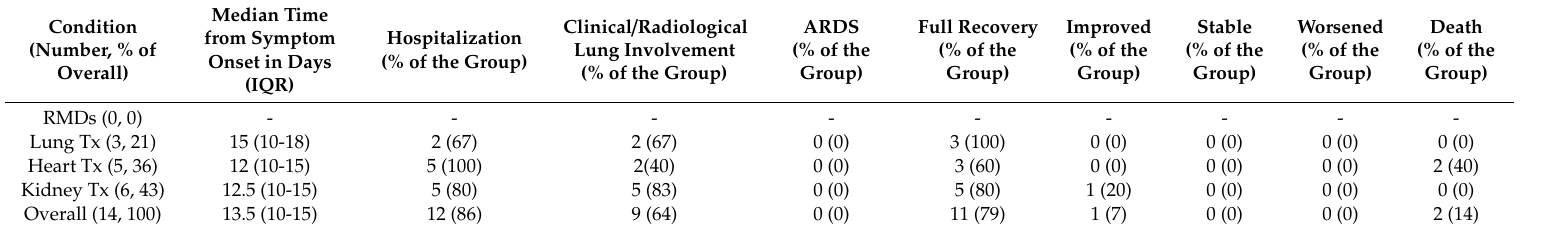
Table 3. Characteristics of the 14 patients with confirmed